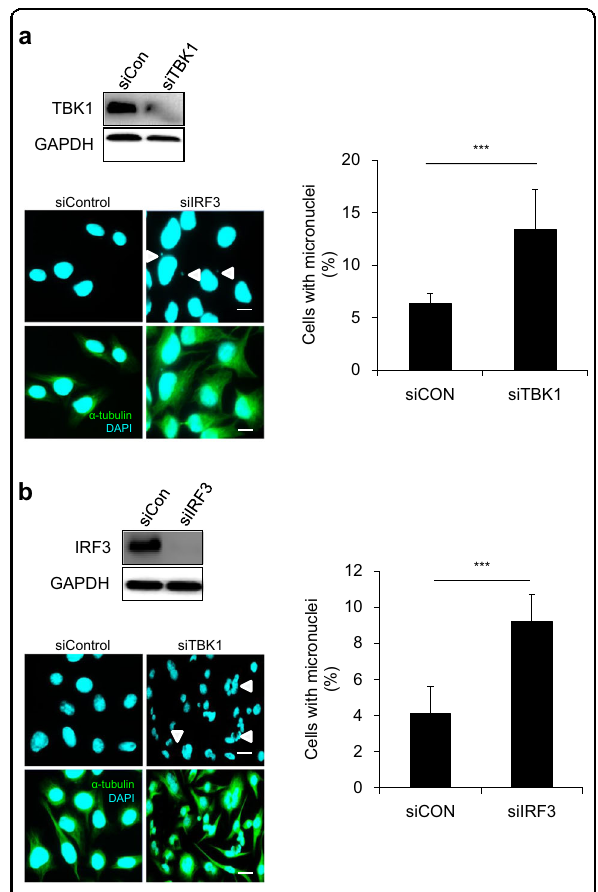
Fig. 5 TBK1 and IRF3 downregulation also promotes the formation of micronucleated cells. a HeLa cells were transfected with siRNA targeting TBK1, and 30 h later they were treated with nocodazole for 16 h. After 16 h, cells were released from arrest and were subjected to western blotting with the indicated antibodies. Mitotic cells collected after nocodazole treatment were reseeded, and ICC was performed to evaluate the percentage of cells with micronuclei; representative fl uorescent images show micronuclei (white arrowhead denotes micronuclei). The results are given as the mean ± SD from three independent experiments ( n = 300). *** P < 0.001 as assessed by Student ’ s t -test. b IRF3 was downregulated by RNA interference in HeLa cells for 30 h, and then cells were treated with nocodazole for 16 h. After 16 h, cells were released from arrest, and mitotic cells were collected and subjected to ICC (right panel) to evaluate the percentage of cells with micronuclei; representative fl uorescent images show micronuclei (white arrowhead denotes micronuclei). Western blotting was performed with the indicated antibodies to con fi rm IRF3 knockdown via siRNA transfection (left